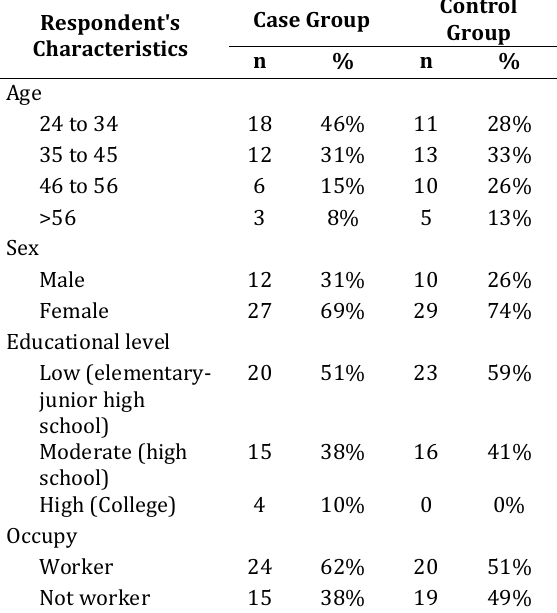
Table 1. Respondent’s Characteristics